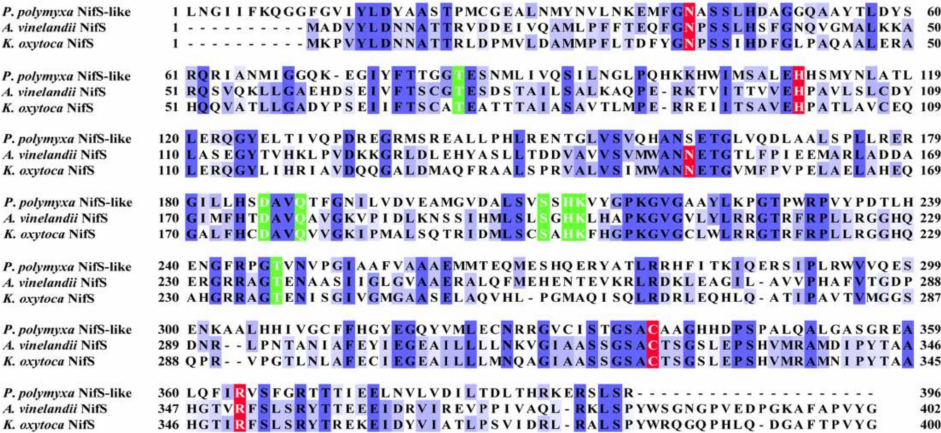
Figure 3. Comparison of amino acid sequences of the NifS-like protein from P. polymyxa WLY78 and NifS from A. vinelandii and K. oxytoca . Amino acid sequences were aligned using the Clustal Omega program (https://www.ebi.ac.uk/Tools/msa/clustalo/, accessed on 25 March 2021). Conserved residues involved in pyridoxal-phosphate (PLP) binding and activity are indicated by a green background. Invariable cysteine and other residues involved in substrate binding are indicated by a red